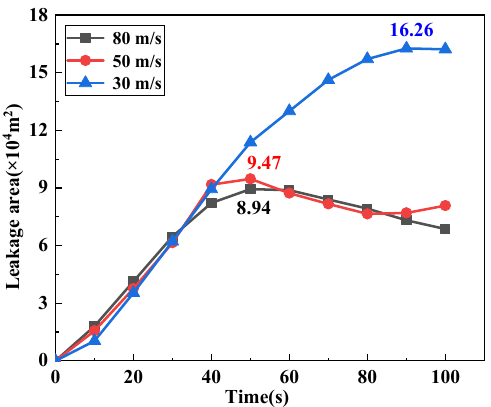
Figure 8. Variation of the diffusion area at different leak velocities.